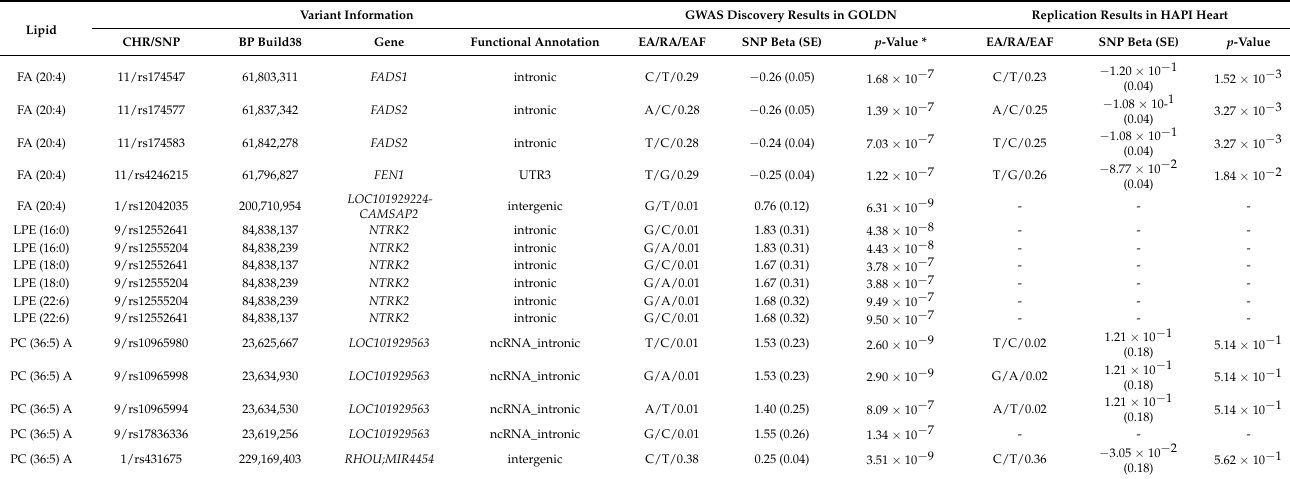
Table 2. Top GWAS findings from the GOLDN lipidomics discovery effort (PPL intervention) and replication in the HAPI Heart Study.